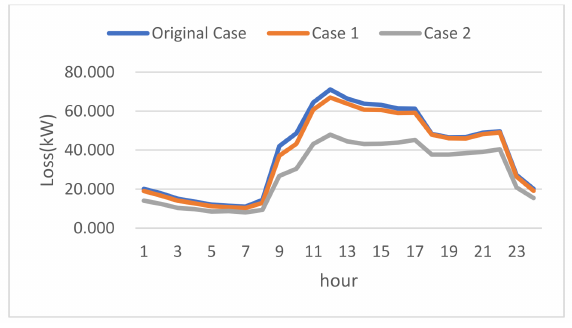
Figure 10. The daily system loss profiles.